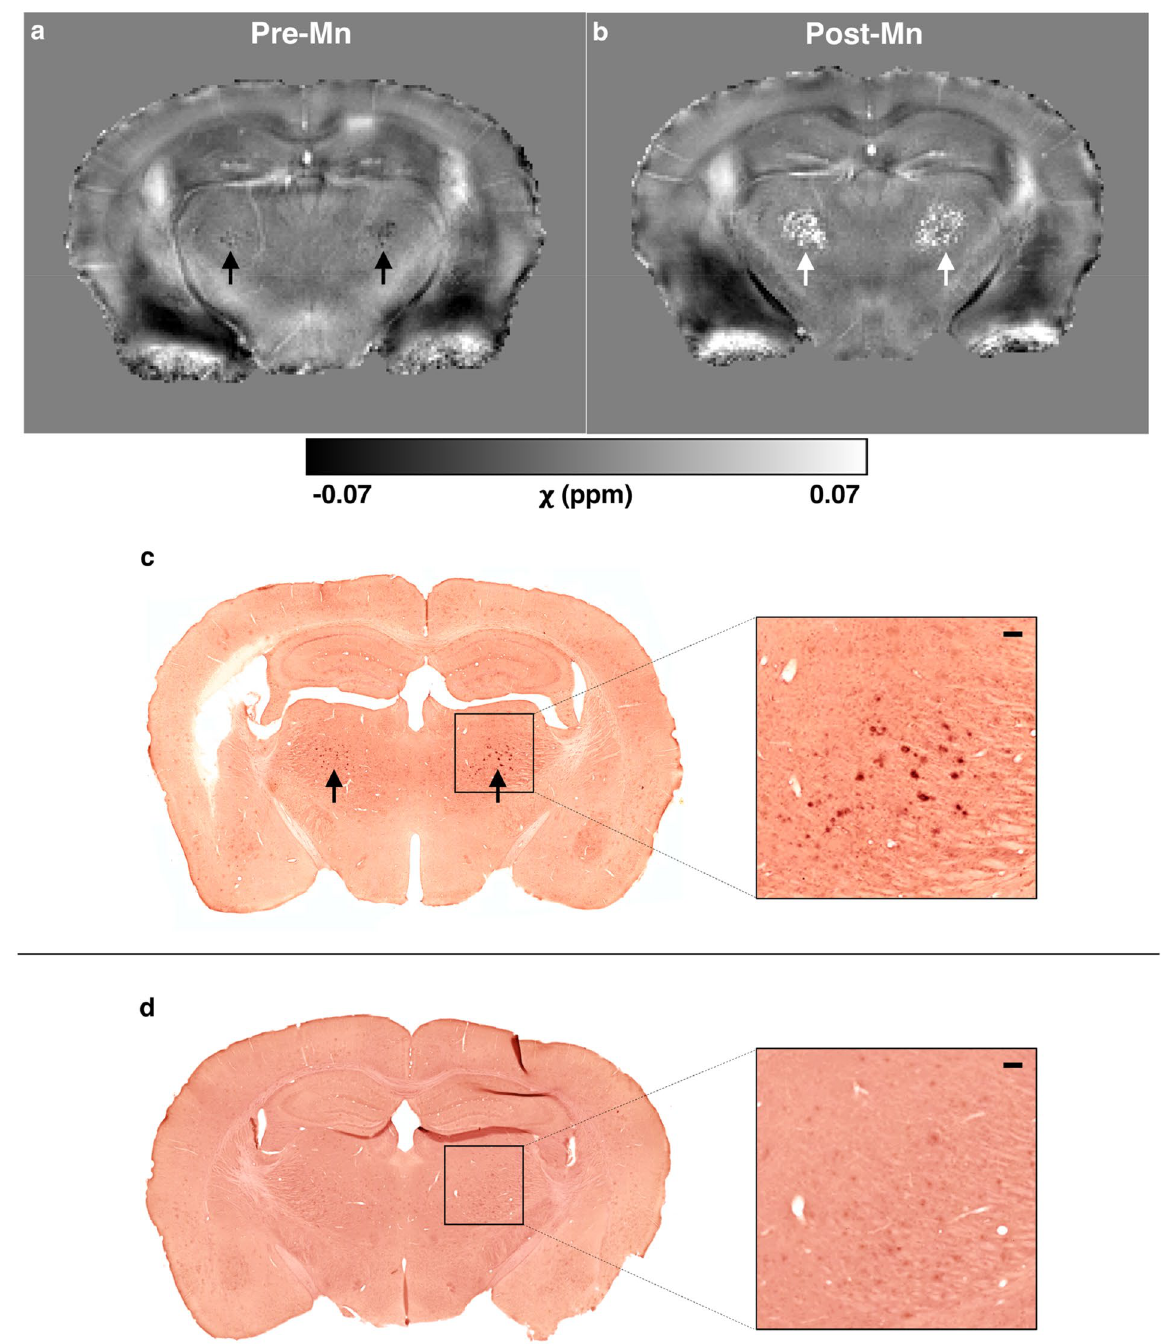
Figure 4. In vivo QSM and Alizarin Red staining reveal thalamic calcifications in 5xFAD mice. ( a , b ) Quantitative susceptibility ( χ ) maps of a 5xFAD mouse ( a ) before (pre-Mn) and ( b ) after administration of MnCl 2 (Post-Mn). Bilateral clusters in the thalamus were diamagnetic Pre-Mn but became paramagnetic Post-Mn (arrows). ( c ) A section from the same mouse, stained with Alizarin Red, shows that these thalamic clusters contain calcium and/or manganese. ( d ) An Alizarin-Red-stained section from a 5xFAD mouse without MR-visible thalamic clusters. Inset scale bars = 100